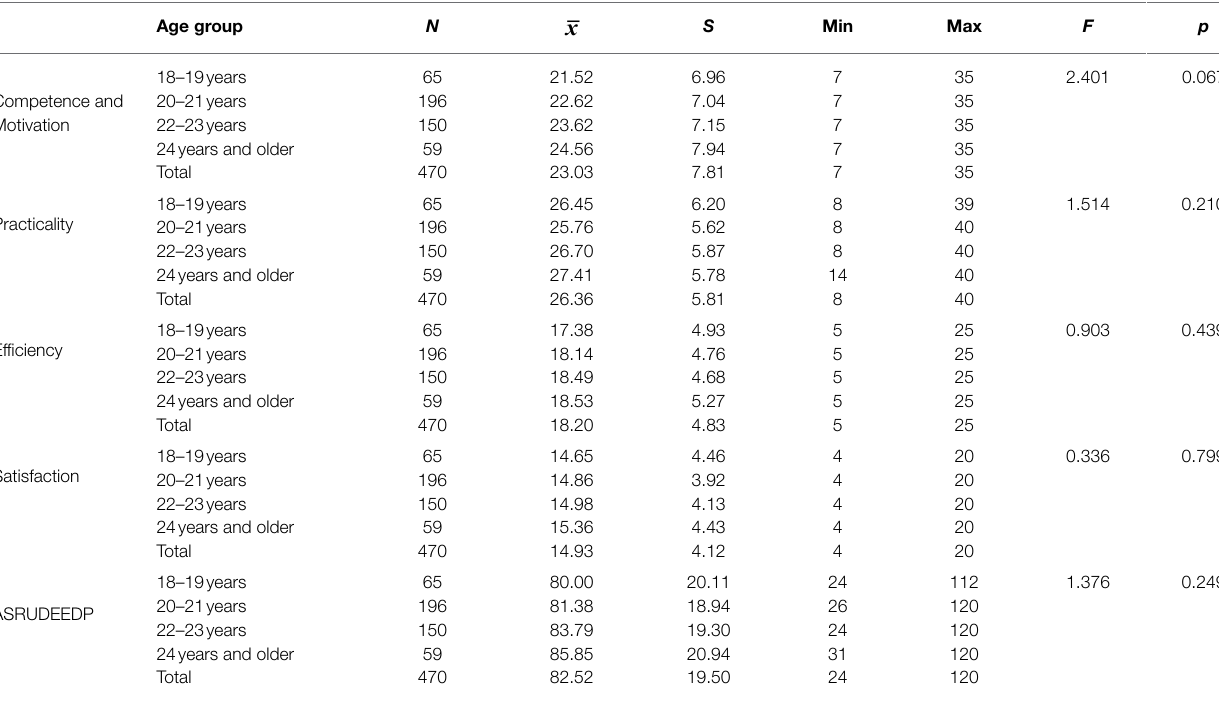
TABLE 1 | Comparison of the students’ scores from ASRUDEEDP according to their age